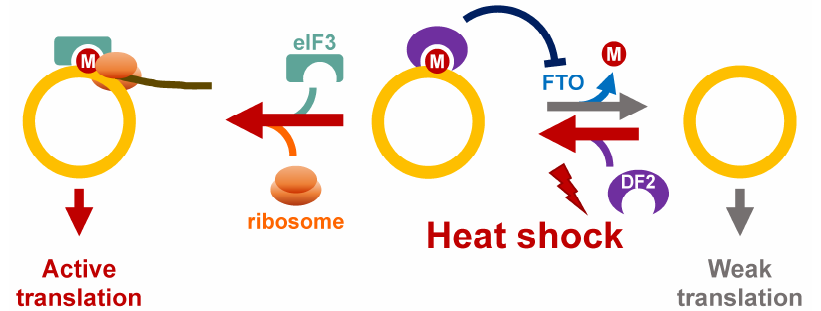
Figure 5. Potential roles of m6A in regulation of circRNA translation in response to heat shock. Upon heat stress, YTHDF2 (DF2) binds m6A-modified circRNA, and prevents FTO-mediated demethylation. The ribosomes are recruited to circRNA through eIF3/YTHDF2.